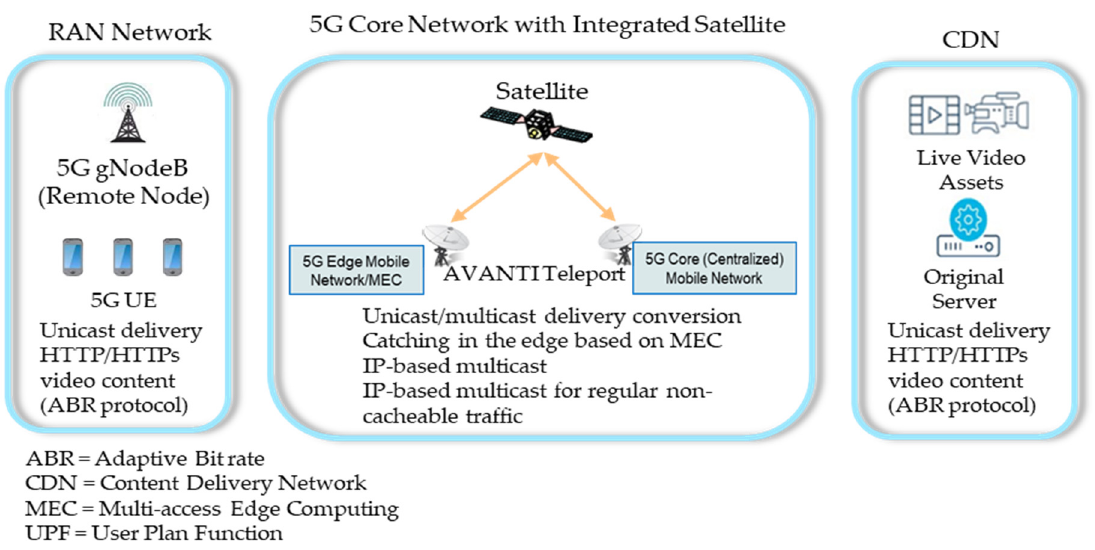
Figure 8. SaT5G Architecture for Use Case 1: Multicast/caching MEC testbed.